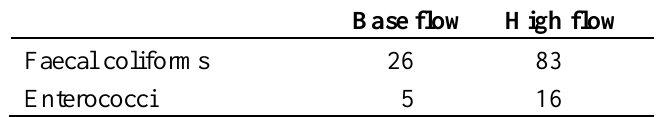
Table 2. Geometric mean faecal coliform and enterococci concentrations (cfu 100 mL −1 ) in waters issuing from lakes and reservoirs, based on data from Nant-y-Moch and Cwm Rheidol Reservoirs in Afon Rheidol/Ystywyth study, Lake Windermere in the